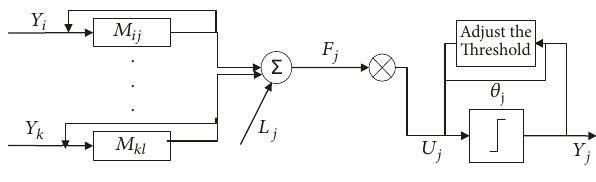
Figure 2: Modified PCNN model